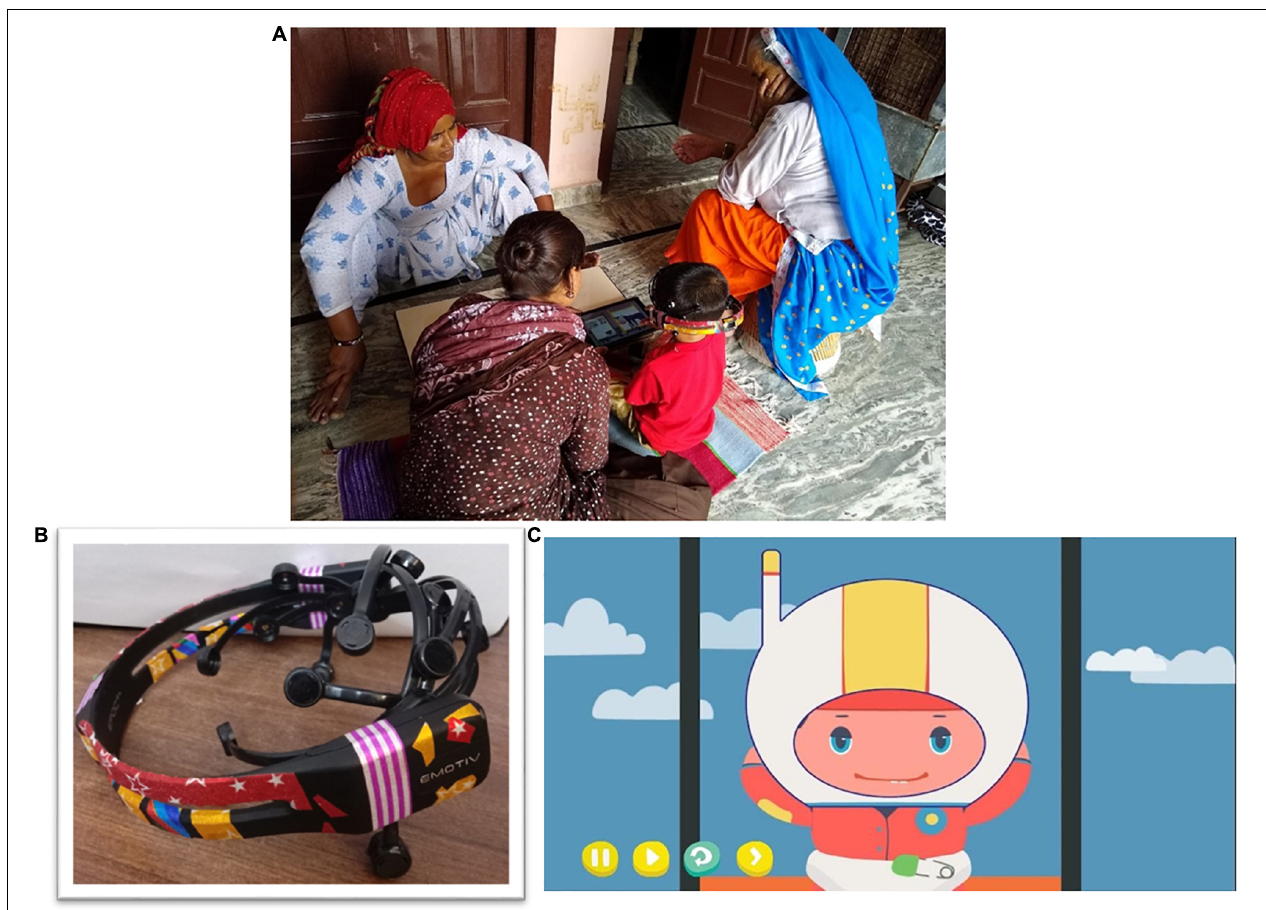
FIGURE 1 | (A) Example picture of testing in rural households. (B) EMOTIV EPOC decorated with stickers to make it attractive for children. (C) Screenshot of the animated story showing the protagonist wearing a helmet, which was used to encourage children to wear the EEG headset.